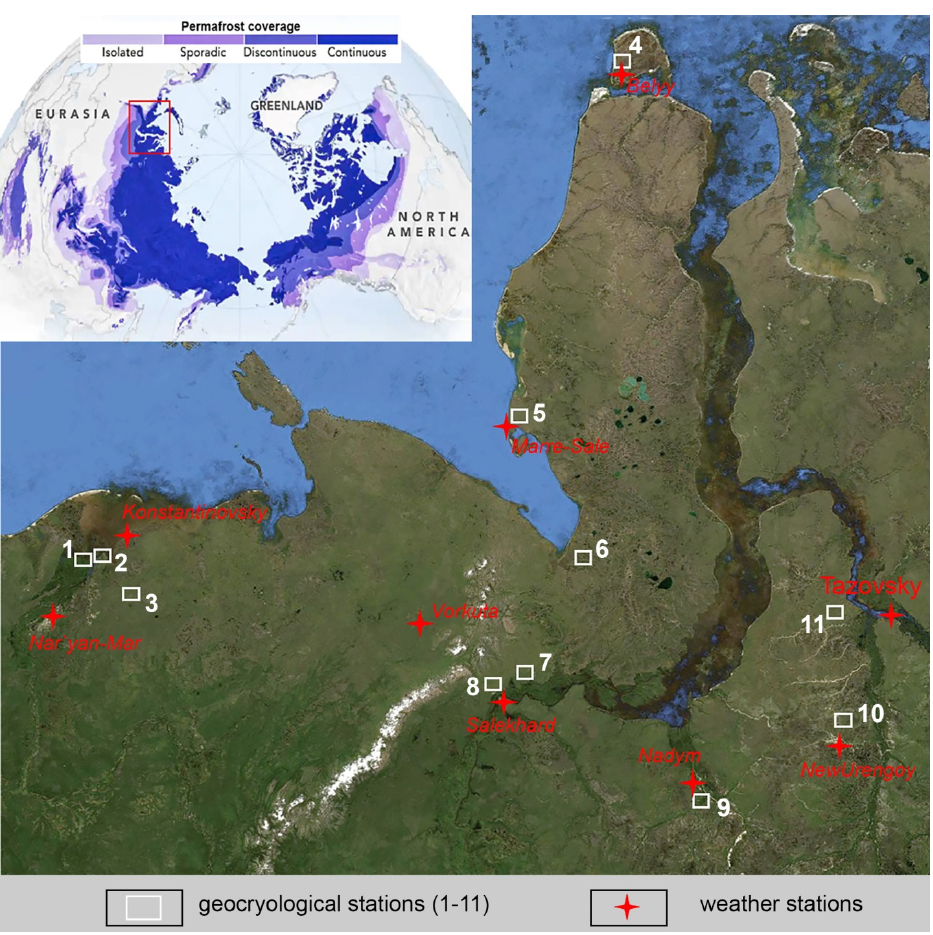
Figure 1. Layout of monitoring facilities and reference meteorological stations of Roshydromet. Sites included in this study: Kashin (1), Bolvansky (2), Shapkina (3), Belyy (4), Marre-Sale (5), Erkuta (6), Oktyabrsky (7), Labytnangy (8), Nadymsky (9), Urengoy-South (10), and Urengoy-North (11). At sites with a regular grid of measurements, which are a part of the international CALM network [17], the position of the permafrost table down to a depth of 2.0 m was monitored using a metal probe. In talik areas with greater depths to the top of permafrost, ground penetrating radar (GPR) and seismic methods have proven to be effective [35–39].